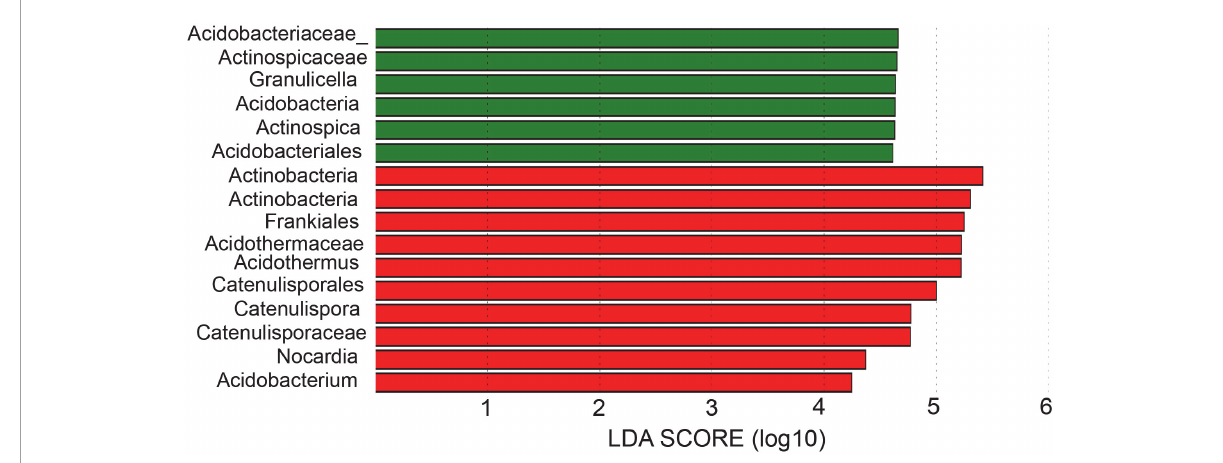
FIGURE4 Linear discriminant analysis effect size (LEfSe) for bacterial taxa between soils of healthy and disease.